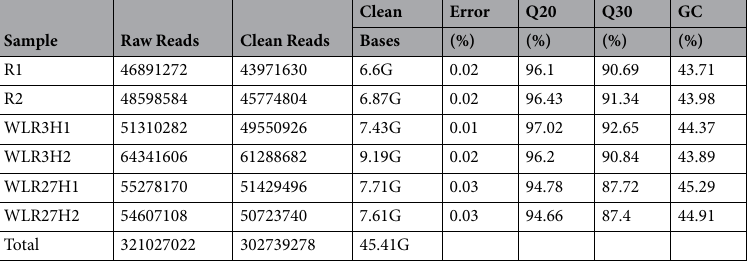
Table 1. Summary of sequences analysis. R, Untreated root; WLR, Waterlogged root; H, Hour; Q20, The percentage of bases with a Phred value > 20; Q30, The percentage of bases with a Phred value > 30.